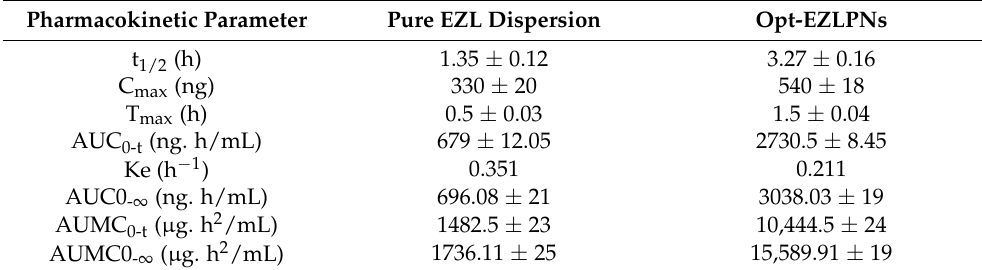
Table 5. Anti ‐ ulcer activity of the EZL ‐ PNopt formulation ‐ treated group compared to other groups.